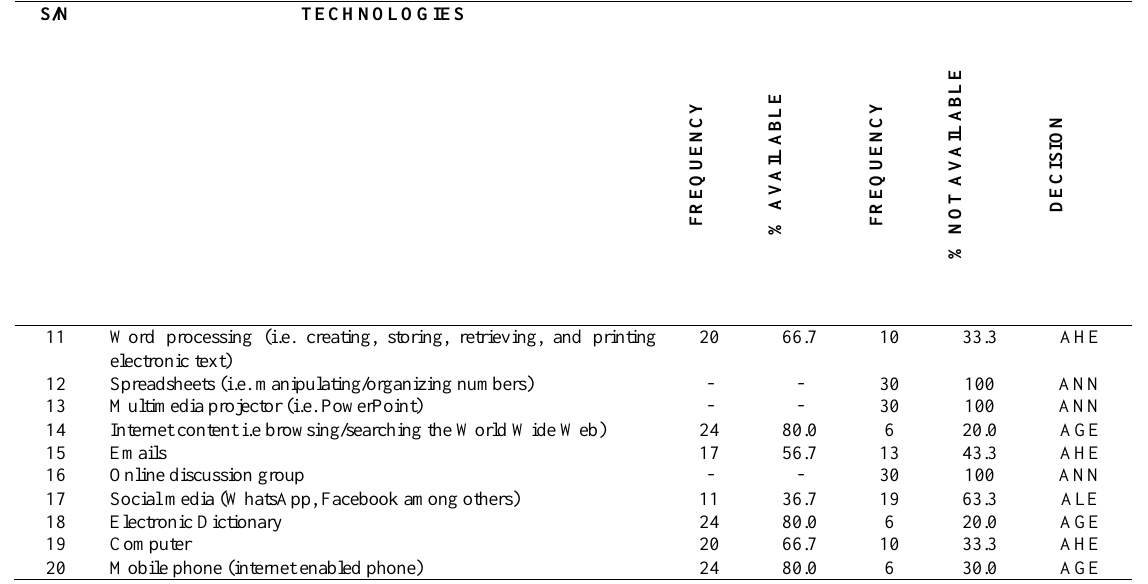
Table II: Frequencies and percentages of the availability of technologies for the teaching of English language in